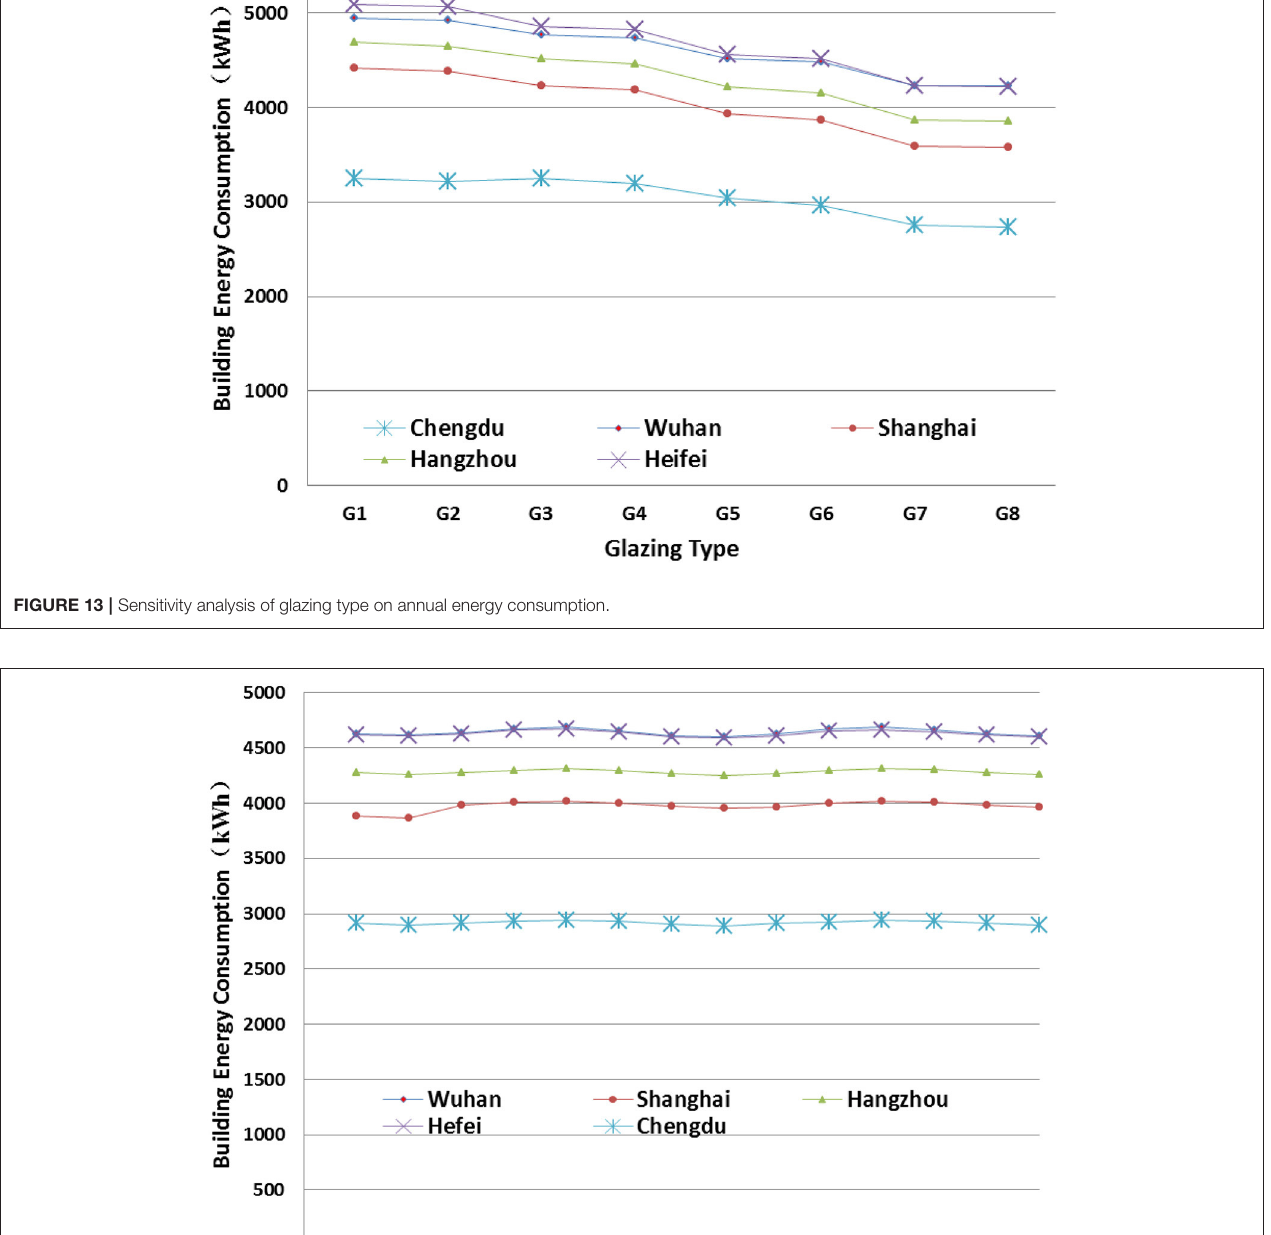
to about 700 h, and theoretically it can be reduced to 0